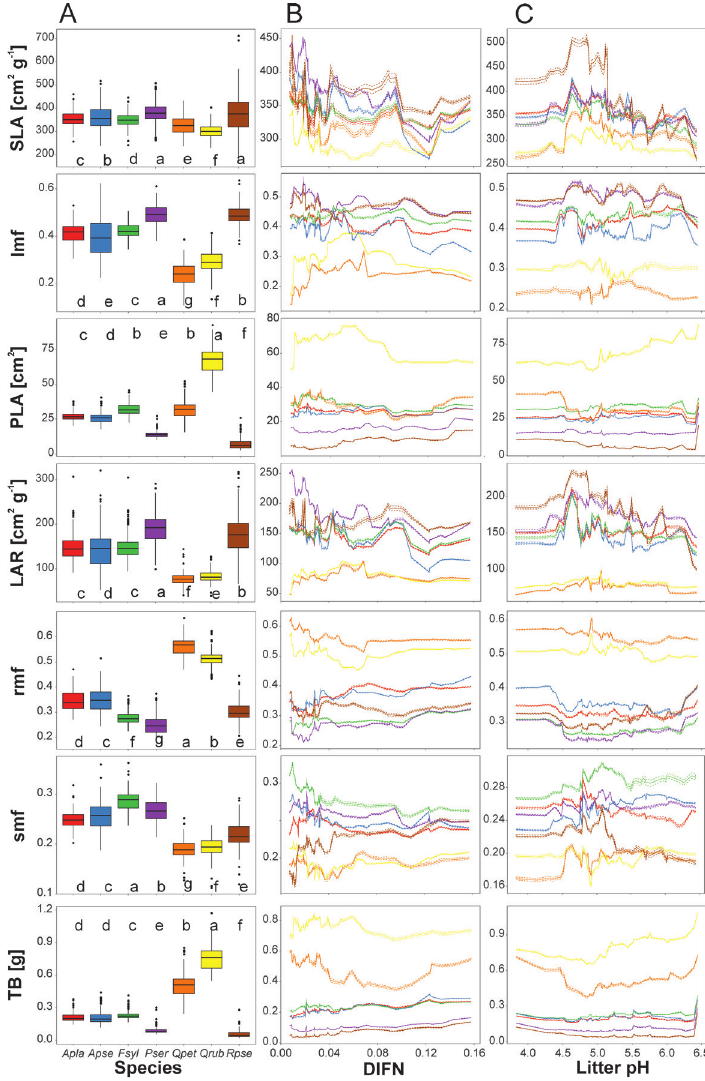
Figure 4. Saplings traits variability of the species studied across predictors explained by a random forest model. Partial dependence plots (ceteris paribus plots) show changes of predicted values when a particular predictor is changed while all remaining predictors are constant (i.e. mean value) – in the middle ( B ) and right ( C ) column we showed interactions between species and DIFN and litter pH. In the left column ( A ) we showed partial group predictions – predicted trait values assuming constant levels of other predictors, boxes represent interquartile range and median, whiskers represent minimum-maximum range, abbrevia- tions of species: Apla – Acer platanoides , Apse – A. pseudoplatanus , Fsyl – Fagus sylvatica , Pser – Prunus serotina , Qpet – Quercus petraea , Qrub – Q. rubra , Rpse – Robinia pseudoacacia ; traits: SLA – specific leaf area, lmf – leaf mass fraction, PLA – projected leaf area, LAR – leaf area ratio, rmf – root mass fraction, smf – stem mass fraction, TB – total biomass. For further details see Table 1. Species marked by the same letter did not exhibit significant statistical difference in predicted trait values, according to the Tukey posteriori test at